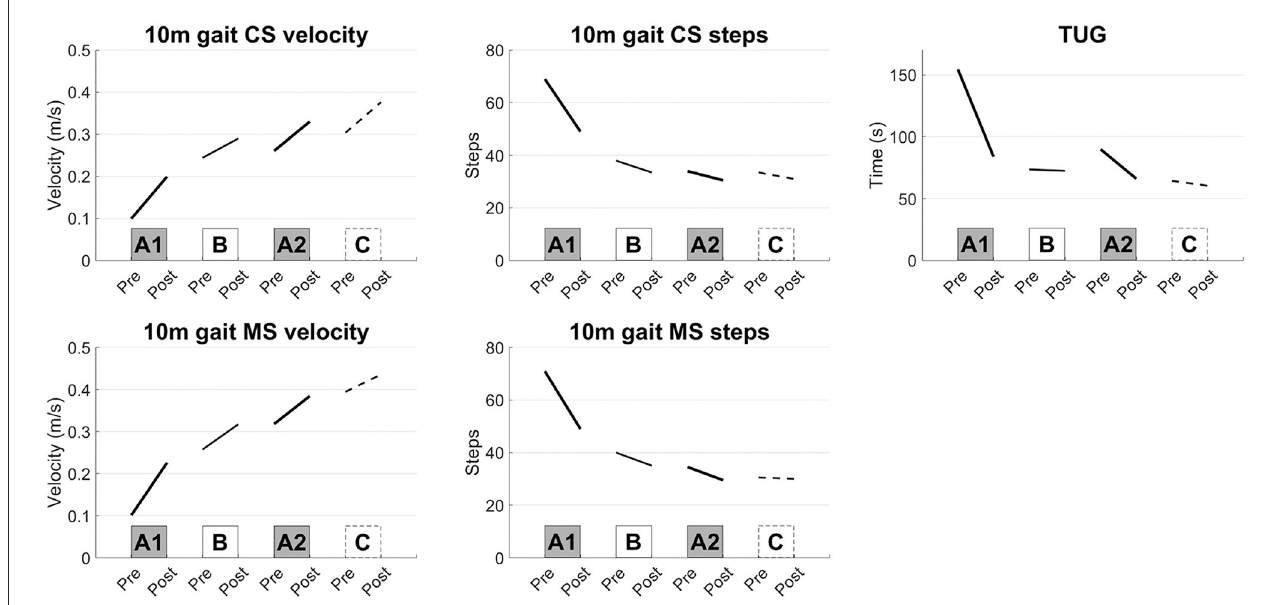
FIGURE1 Results of the short-term evaluations. Synchronized stimulation improved the gait speed measured by the 10-m gait test, TUG test, and muscle strength of the lower limbs (interventions A1 and A2), whereas sham or asynchronized stimulation did not improve the gait speed (interventions B and C). 10m gait